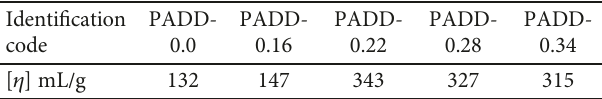
Table 4: Intrinsic viscosity of the